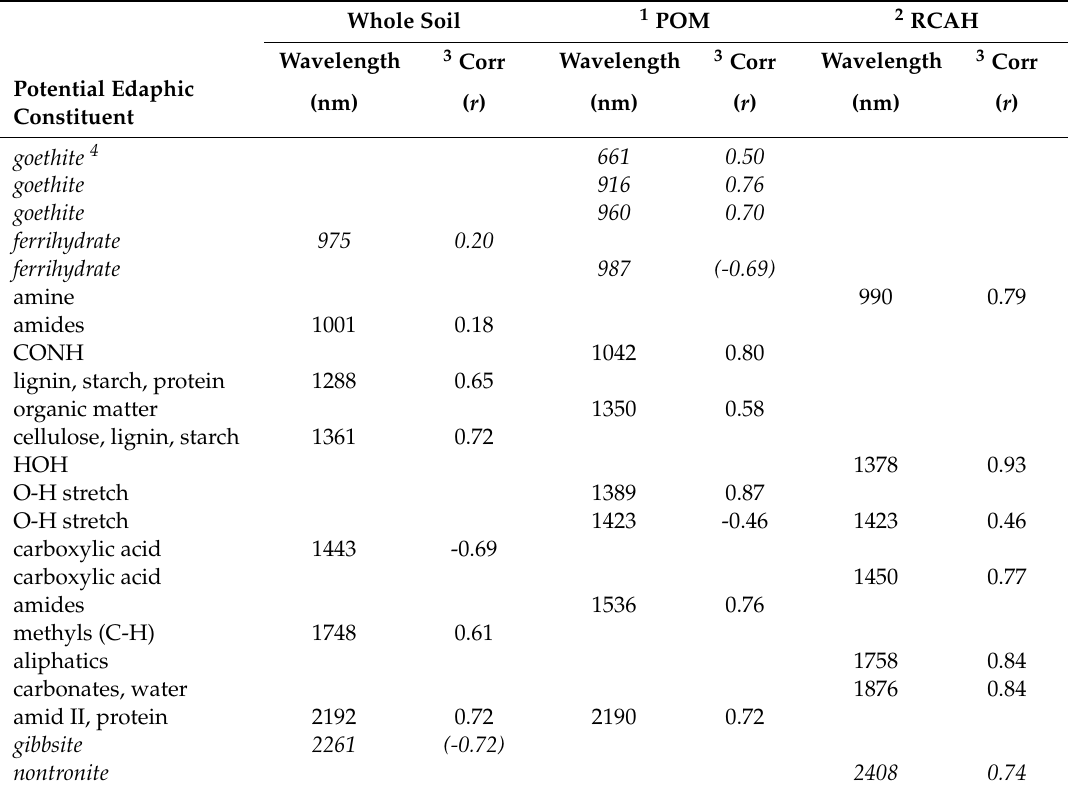
Table 6. Correlation (r, y-axis) and reflectance at a given wavelength (x-axis) with whole soil (C or